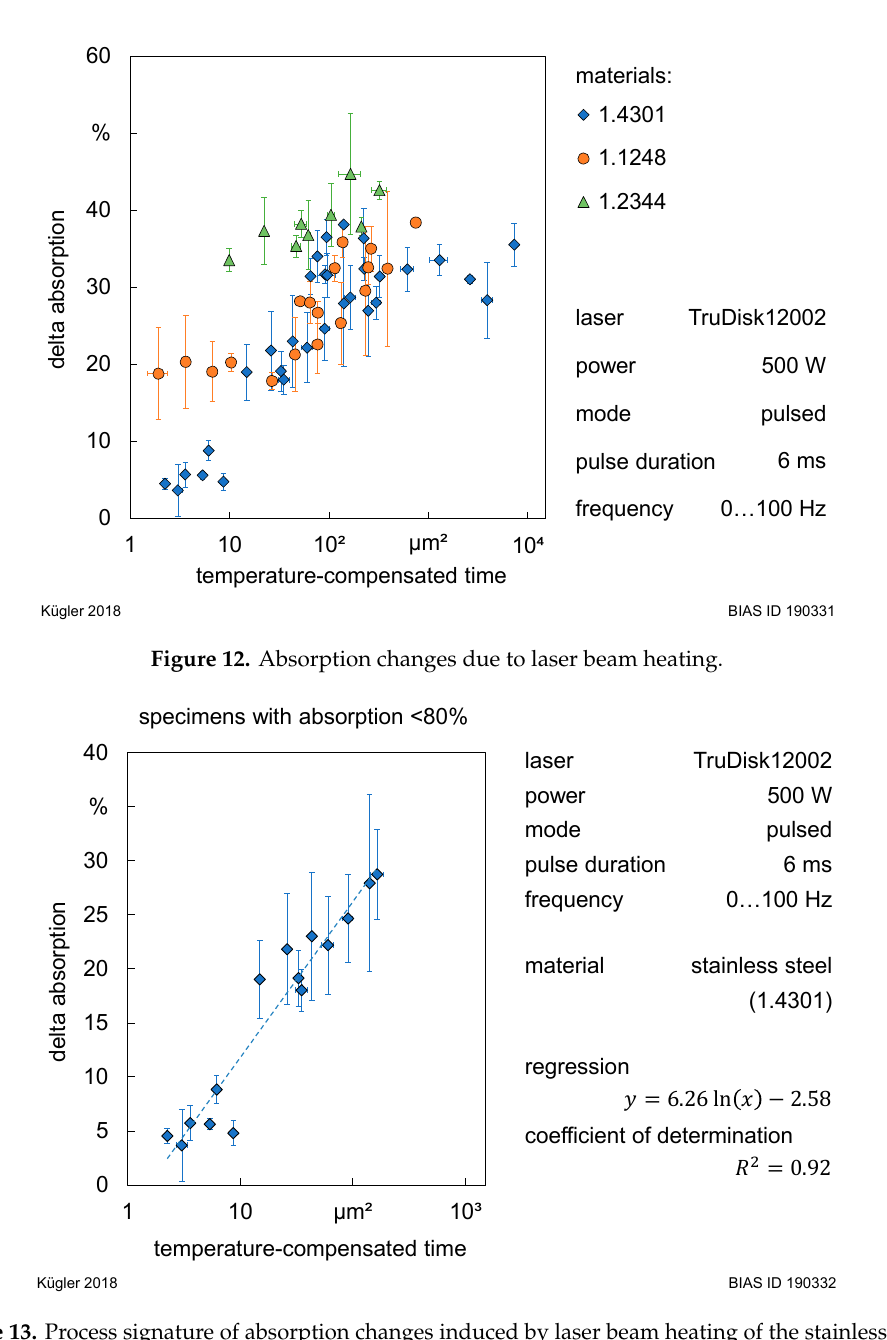
Figure 13. Process signature of absorption changes induced by laser beam heating of the stainless steel sheets (1.4301).